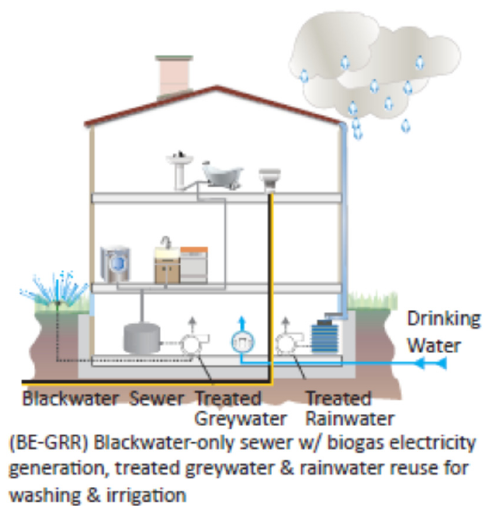
Figure 1. Water system configurations. Reprinted with permission from [37].